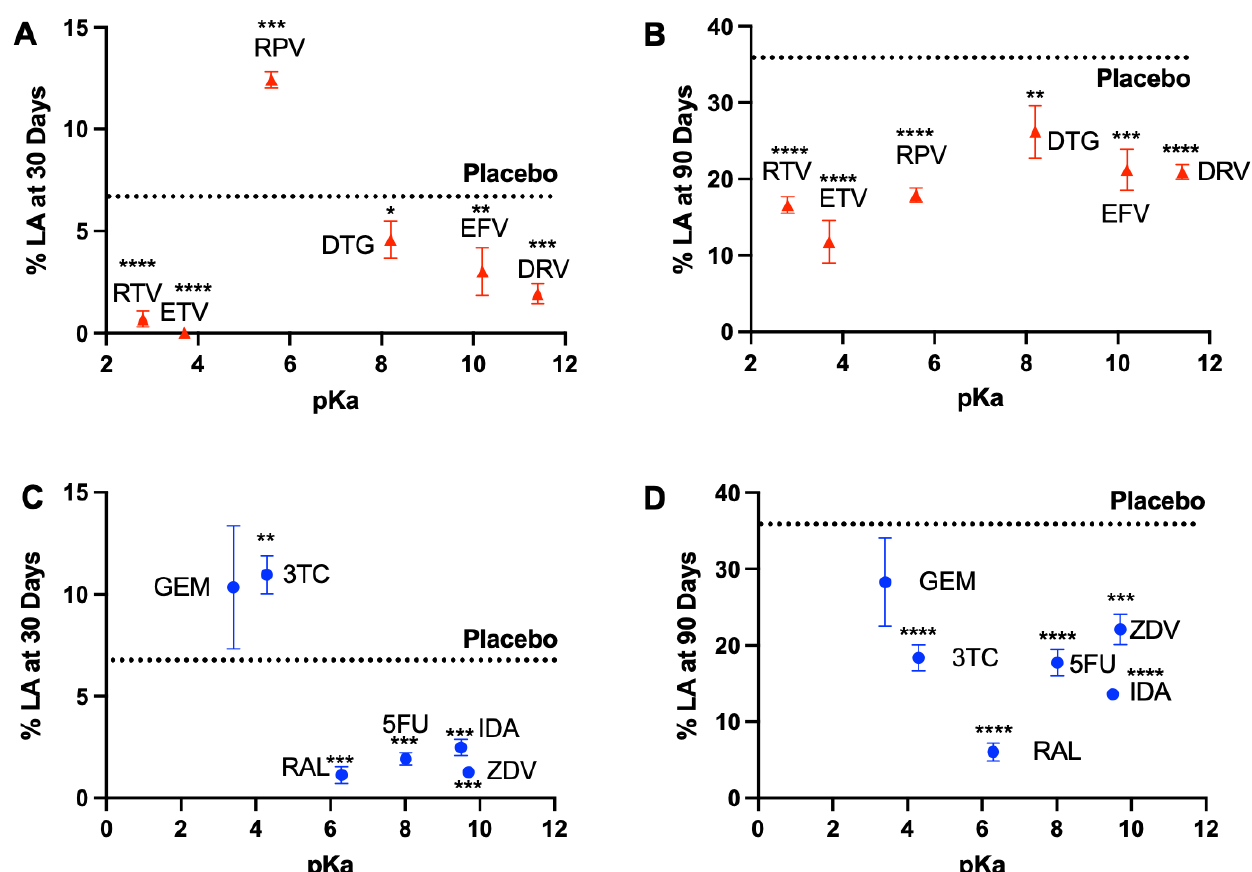
Figure 5. Cumulative percent in vitro release of lactic acid from drug-loaded ISFIs (50 mg/g drug in